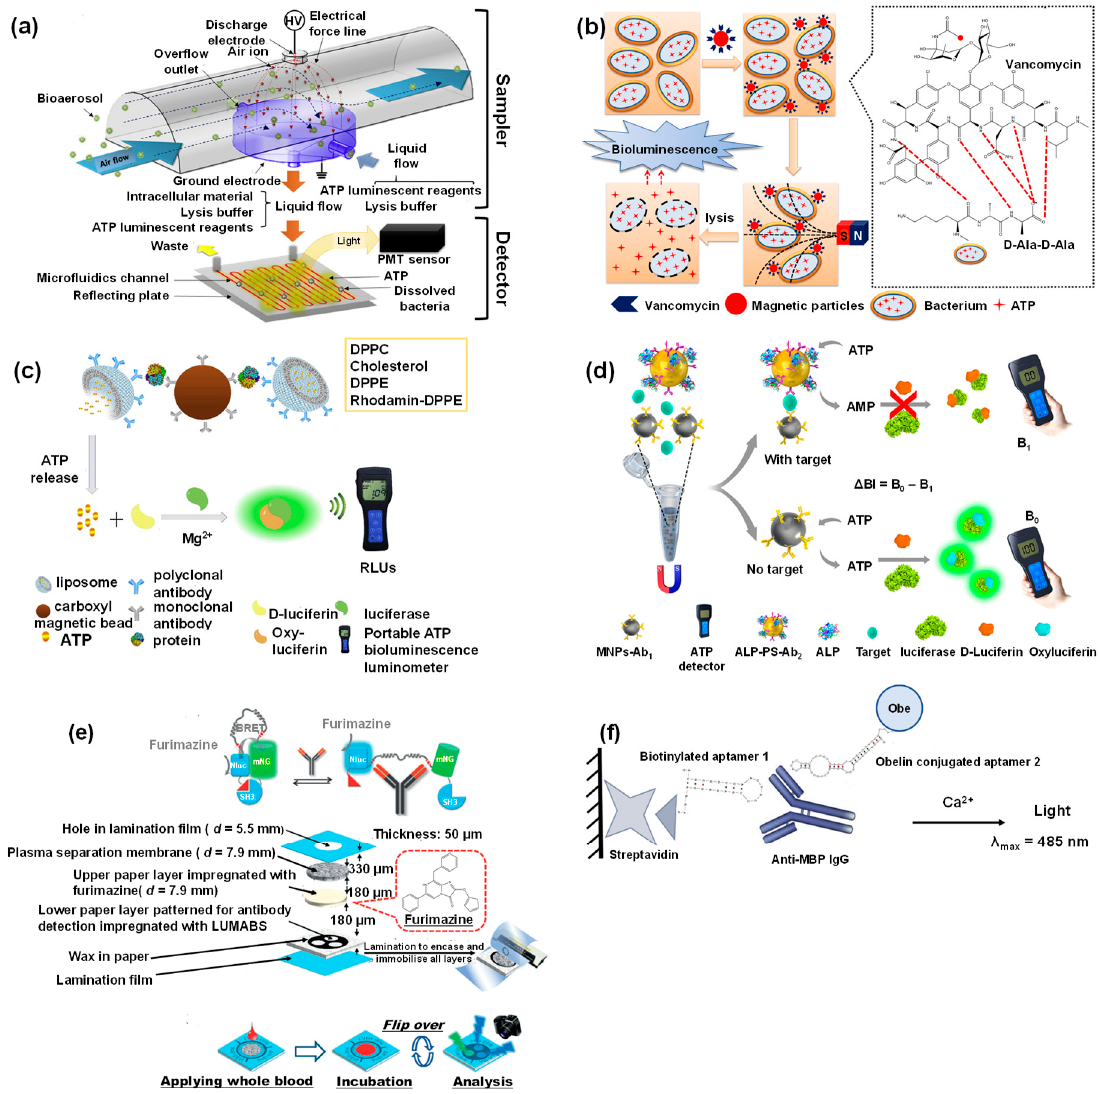
Figure 10. ( a ) BRET-based real-time bioaerosol monitoring device [186]; ( b ) Vancomycin conjugated magnetic particles for gram-positive bacteria detection [187]; ( c ) Magnetic nanoliposomes for bioluminescent protein sensing [196]; ( d ) Magnetic sandwich assay for procalcitonin detection [197]; ( e ) Furimazine-based antibody detection using LUMABS [202]; ( f ) Obelin as a photoprotein in the sensing of anti-myelin basic protein autoantibody [210]. Abbreviations: Ab: Antibody; Ala: Alanine; ALP: Alkaline phosphatase; AMP: Adenosine monophosphate; ATP: Adenosine triphosphate; B 0 /B 1 : Bioluminescence intensity; DPPC: 1,2-Dipalmitoyl-sn-glycero-3-phosphocholine; DPPE: 1,2- Dipalmitoyl-sn-glycero-3-phosphoethanolamine; IgG: Immunoglobulin G; MBP: Myelin basic protein; MNP: Magnetic nanoparticles; PMT: Photomultiplier tube; PS: Carboxyl modified polystyrene microsphere; Obe: Obelin. Reproduced with permission from [186,187,196,197,202,210].